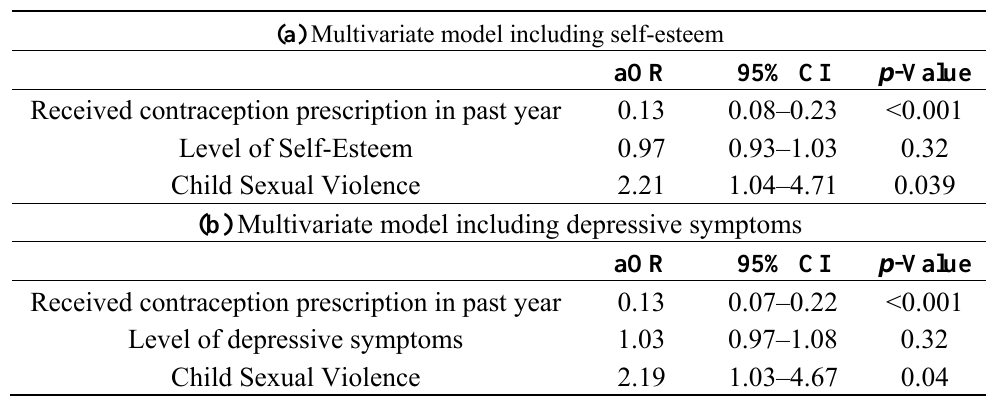
Table 3. Multivariate models. ( a) Multivariate model predicting inconsistent vs. consistent contraception users among young, urban women; ( b) multivariate model predicting inconsistent vs. consistent contraception users among young, urban